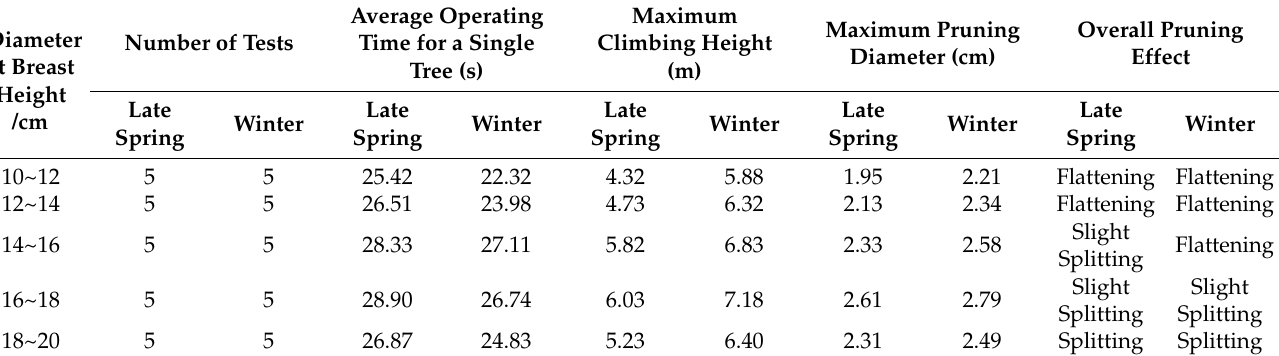
Figure 16. Pruning effect. ( a ) Flattening; ( b ) Slight Splitting; ( c ) Splitting. Table 5. Test indicators and their results.